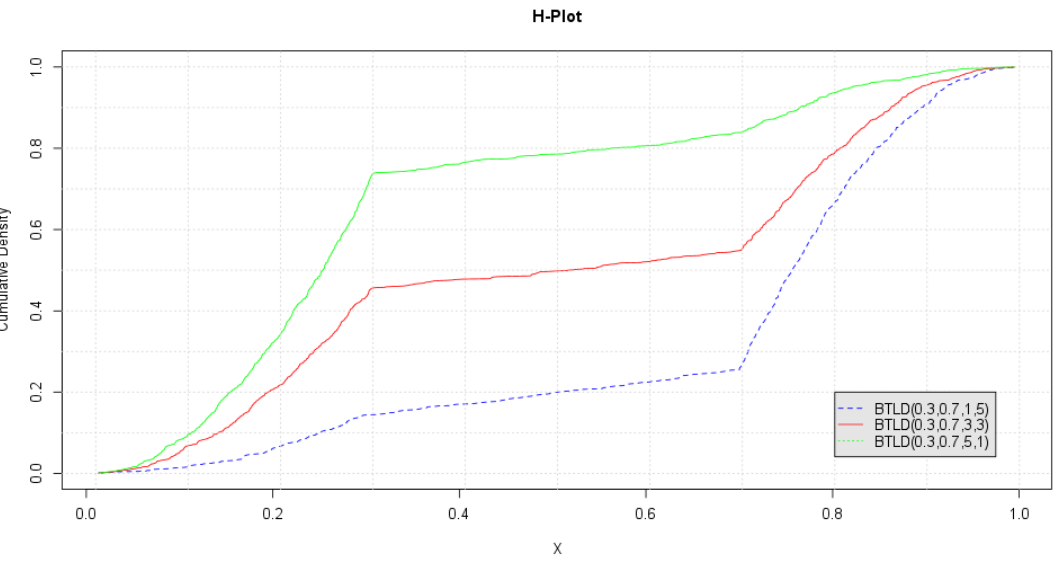
Figure 6. Empirical marginal CDFs of X